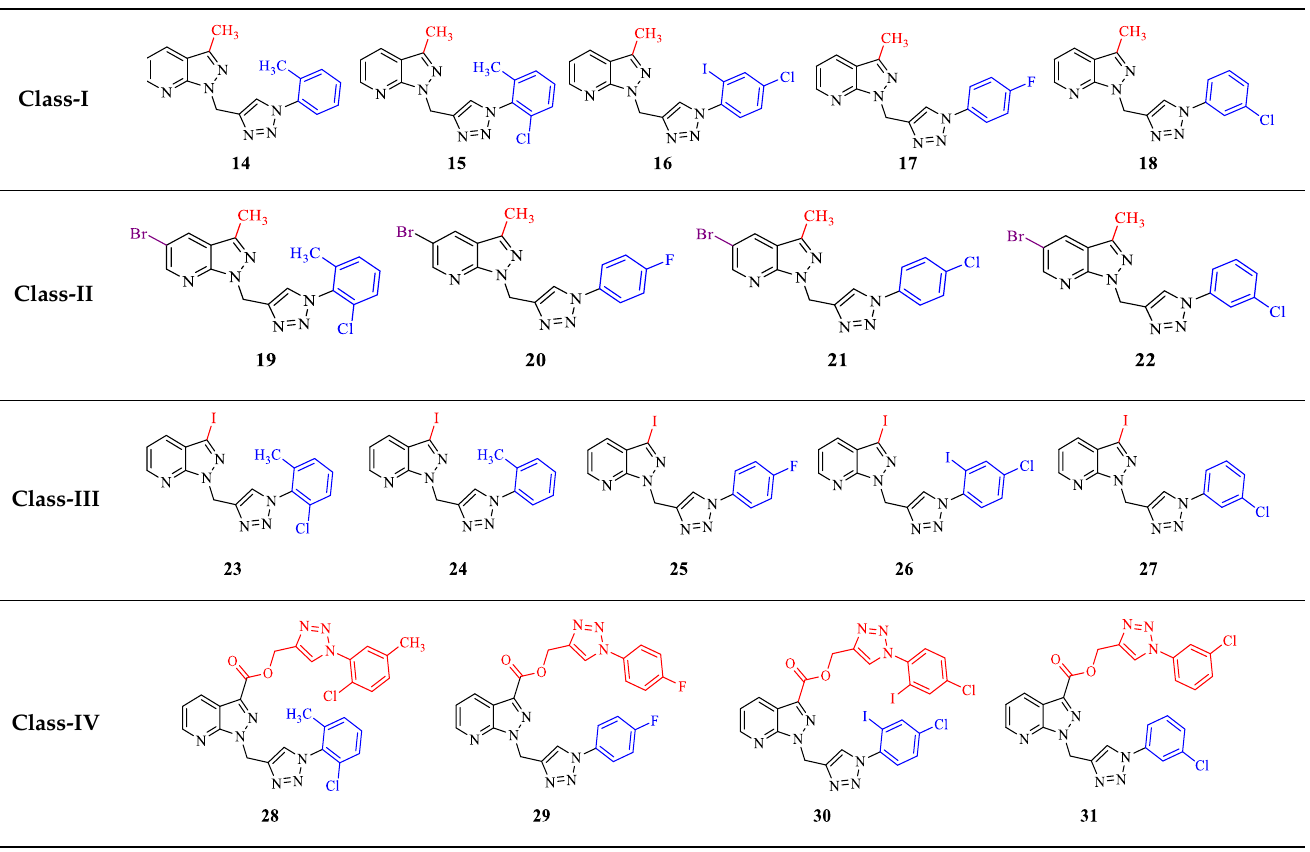
Table 1. The structures of synthesised pyazolo[3,4- b ]pyridine and triazole molecular hybrids.